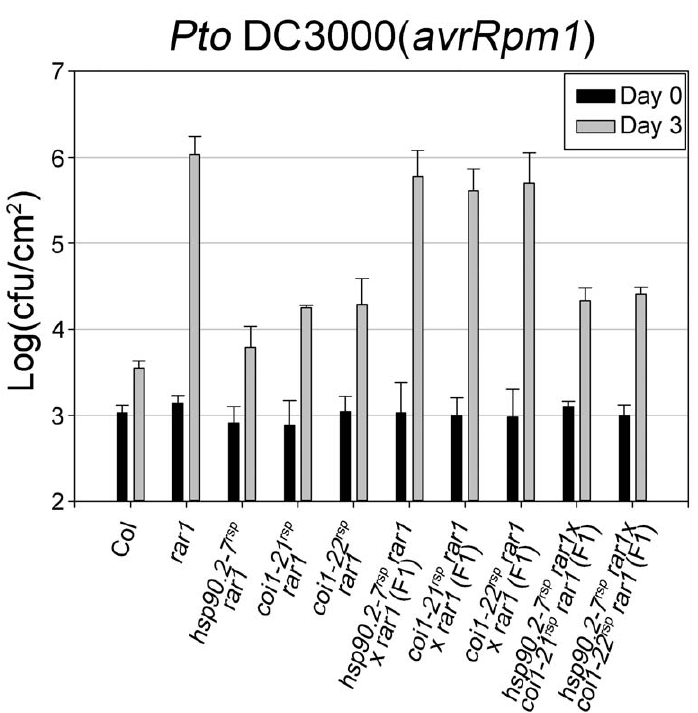
Figure 2. COI1 and HSP90 interact genetically to regulate disease resistance. Bacteria Pto DC3000( avrRpm1 ) were hand-infiltrated into leaves of each indicated genotype and counted at day 0 and day 3. Error bars represent 2 6 SE. The result displayed is one of two independent analyses giving similar results.